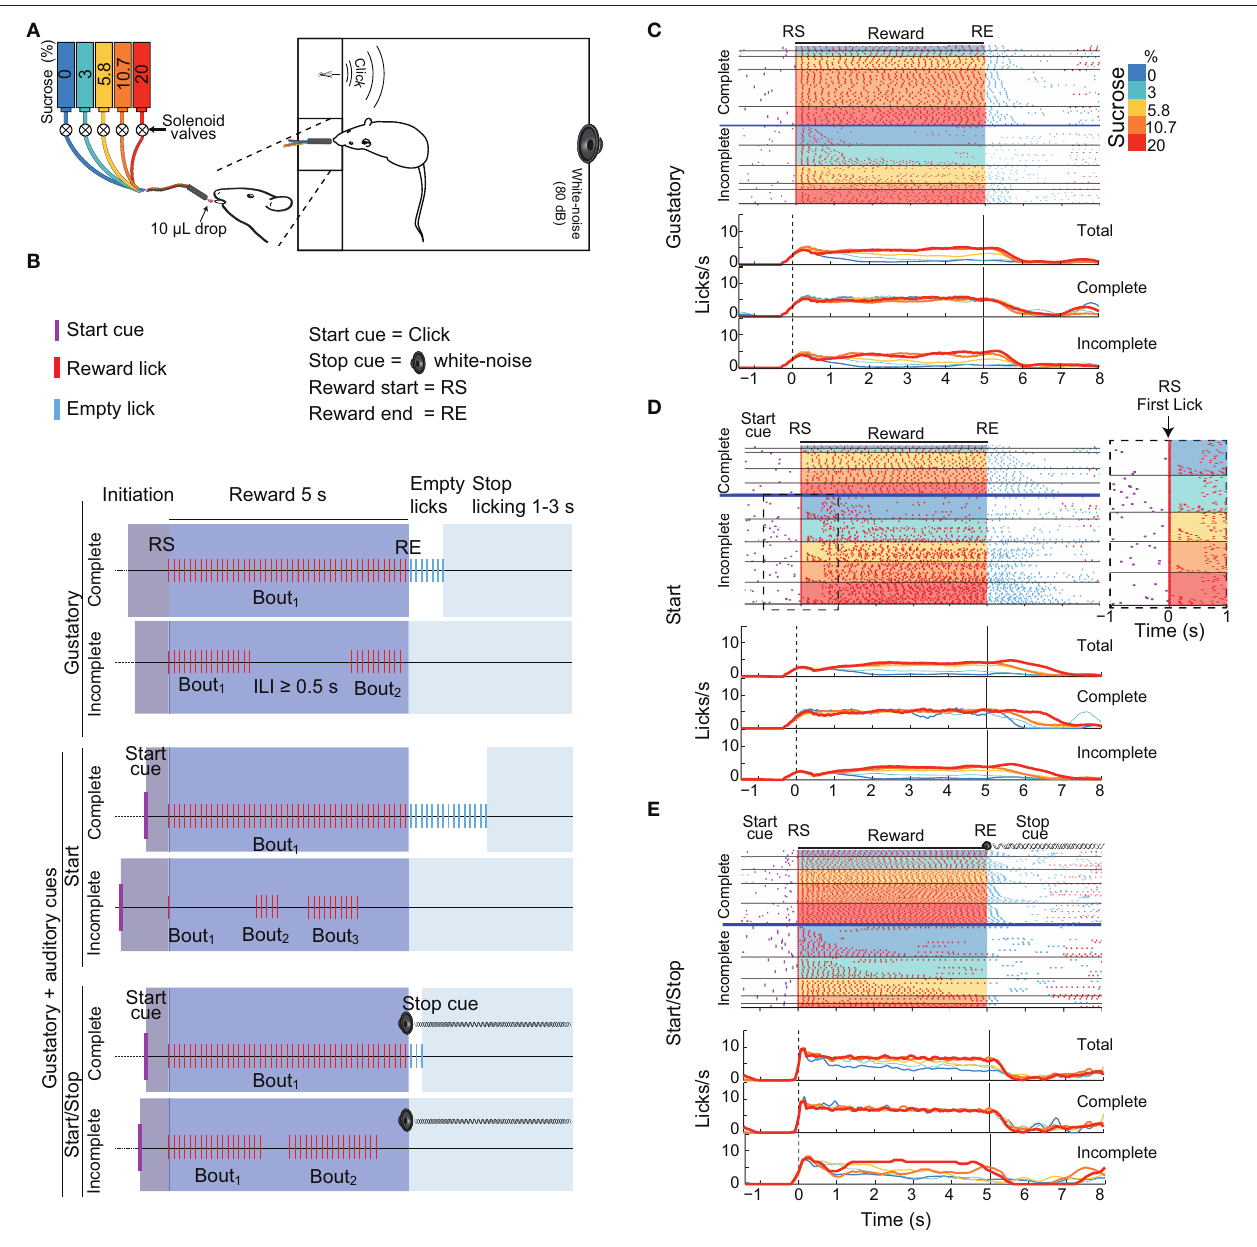
FIGURE 1 | Three variants of the brief-access taste tests used in this study. (A) Schematic showing a rat in a behavioral box with a tastant delivery system. The box was equipped with a sipper that delivers, in each lick, a drop of either water or concentrations of sucrose (color-coded). Also seen are two instruments that produce auditory cues: a “click” and a white-noise cue. (B) Schematics of the structure of trials in the Gustatory (upper) and the two Gustatory + auditory (bottom) variants (Start and Start/Stop) of the brief-access tests. The depicted trials are colored as a function of four epochs: Initiation (gray), Reward (blue), Empty licks (white) and Stop licking (cyan). RS indicates the Reward Start, whereas RE shows the Reward End. All trials were classified as being either Complete (where animals lick continuously emitting one single bout) or Incomplete (where they pause licking at least once for an inter-lick interval (ILI) ≥ 0.5s). In the Gustatory variant, there are no auditory cues, whereas, in the Start task, the Start cue (purple ticks) signals that a new tastant becomes available. In the Start/Stop task there is also a Stop (white noise) cue that commences at RE and continues until the timeout of the Stop licking epoch has finished. (C–E) Representative raster plots from three different animals (upper panels) and PSTHs (bottom panels; all aligned to RS, time = 0s) of licking responses (red ticks) illustrating the Gustatory (C) , the Start (D) , and the Start/Stop (E) variants of the brief-access tests. In all cases, trials were sorted as a function of the sucrose concentration (see colored scale at right) and lick bout duration. The horizontal blue lines separate Complete from Incomplete trials. The Inset (dashed rectangle in D ) is a zoom from the raster plot of the Incomplete trials in a Start brief-access test, highlighting a large number of trials with one-lick bouts (see arrow). The upper PSTHs was for all (Total) trials, the middle panels for Complete trials, and the bottom panels for Incomplete trials. Note that the licks/s in the Incomplete trials track the sucrose palatability.